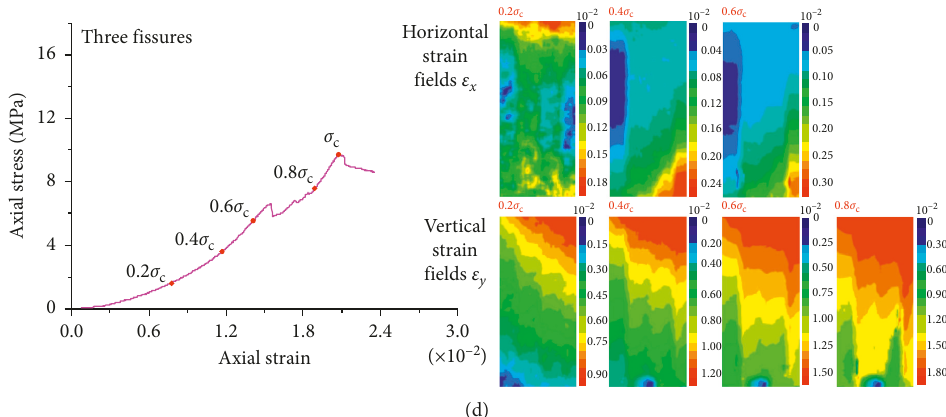
Figure 7: Deformation fields of specimens before peak stress: (a) intact specimens, (b) one fissure specimen, (c) two fissure specimens, and (d) three fissure specimens.